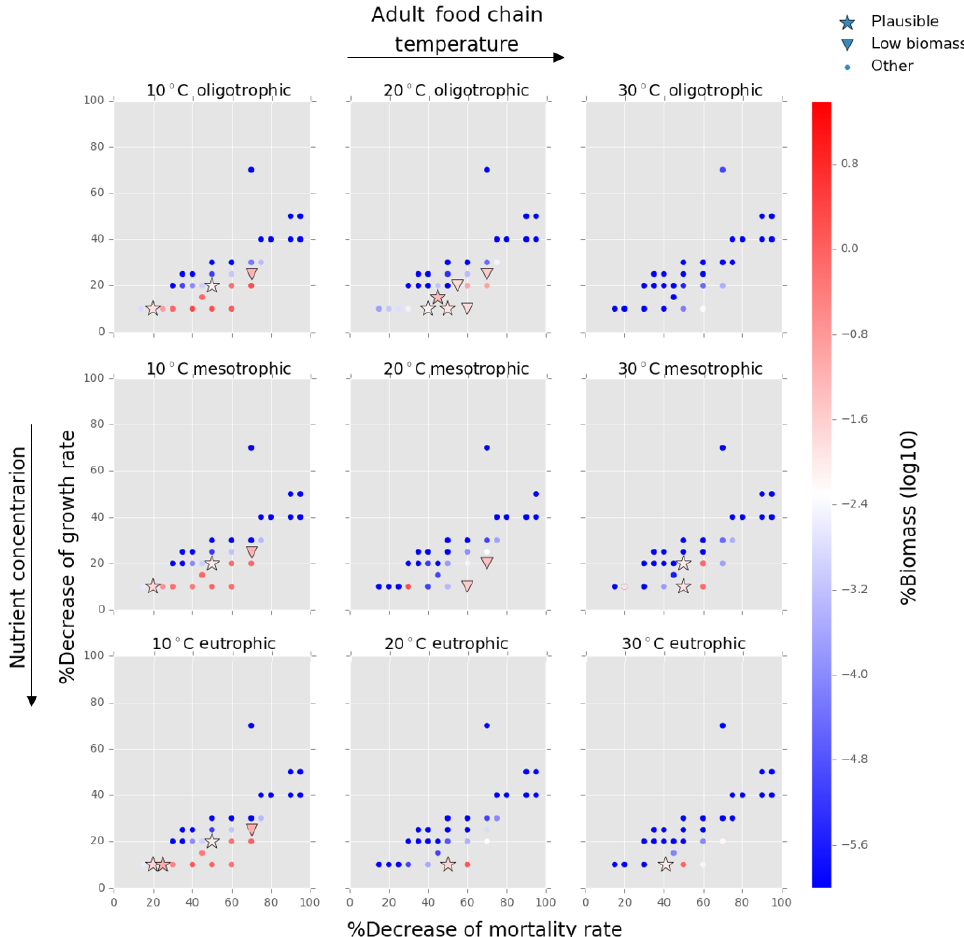
Figure 5. Results from the food chain model for the calcification cost (reduction of growth) and benefit (reduction of mortality rate) for the adult life stage of planktonic foraminifera. Legend shows other for total tested simulations, low biomass for simulations for which their biomass is within the defined range and plausible for the simulations we consider to be as most likely. More details on low biomass and plausible simulations are given in Sect. 2.3, “Adding planktonic foraminifera to the